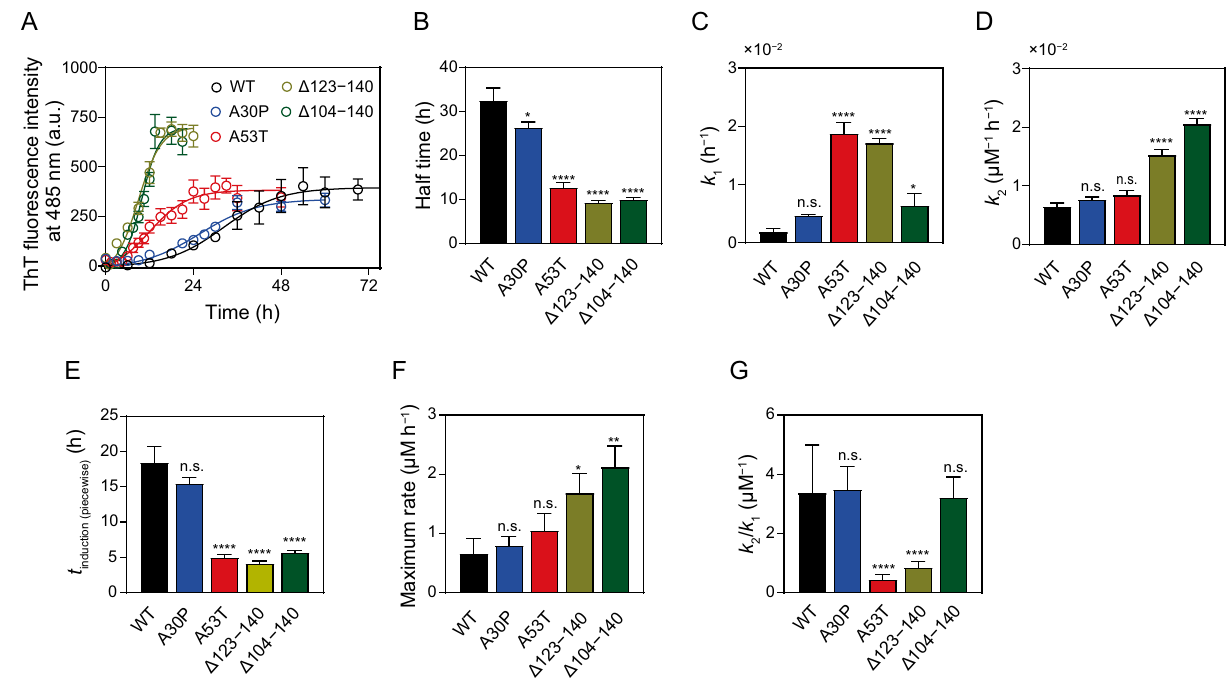
Figure 2. Kinetics of fibril formation of α-syn variants monitored by ThT fluorescence. ( A ) ThT fluorescence traces for α-syn fibrillization. WT (black), A30P (blue), A53T (red), Δ123–140 (yellow), and Δ104–140 (green). Solutions of monomeric α-syn variants (20 μM in PBS, pH 7.4) were incubated at 37 °C with shaking at 500 rpm. Each experiment was repeated at least triplicated. Error bars represent S.E. The solid lines are the fitted curves by the Finke–Watzky 2-step model. a.u. , arbitrary unit. ( B ) Comparison of half time for fibril formation of α-syn variants. Half times were obtained according to the sigmoidal Eq. (1). ( C , D ) Comparison of rate constants for nucleation ( k 1 ) and autocatalytic fibril growth ( k 2 ) of α-syn variants according to the Finke–Watzky Eq. (2). ( E – G ) Comparison of t induction (piecewise) , maximum rate, and k 2 / k 1 ratio for α-syn variants calculated from k 1 and k 2 values according to Eqs. (3) and (4). Error bars represent S.E. * p < 0.05; ** p < 0.01; **** p < 0.0001 versus WT. n.s., not